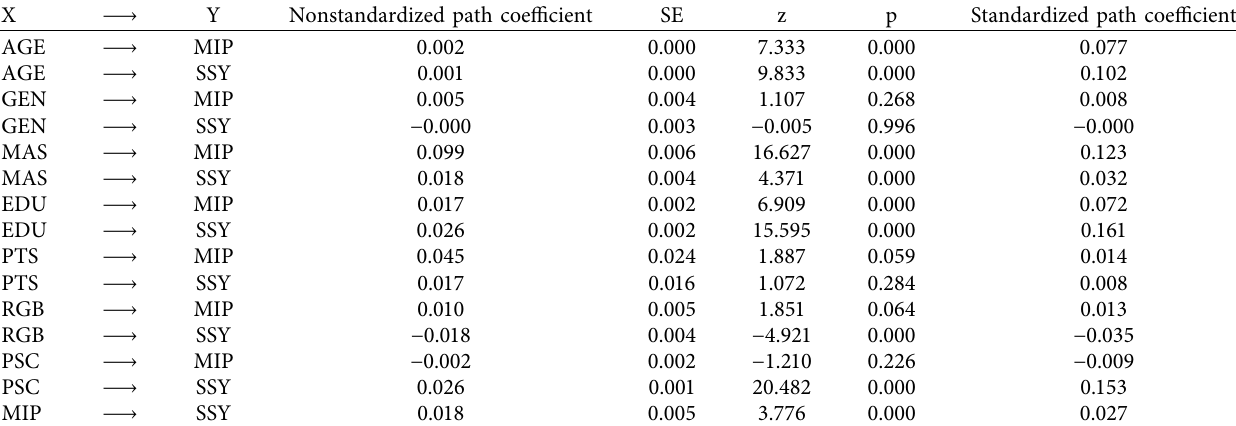
Table 5: Estimated results of the impact of medical insurance on sense of security (rural).